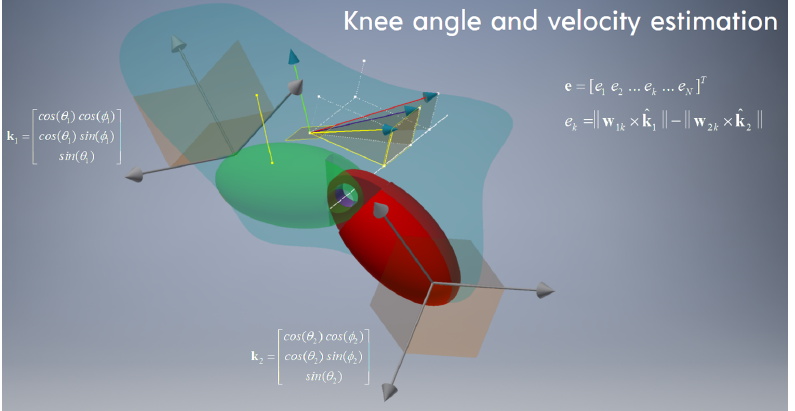
Figure 5. Arbitrary IMU orientation. T1 and T2 indicate the local frames of IMU1 and IMU2,